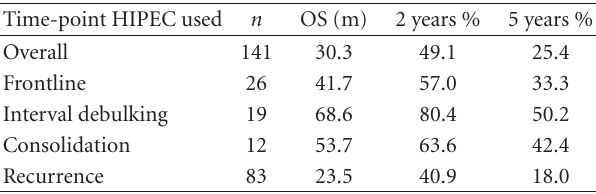
Table 2: Survival rates in HYPERO study. Adapted from